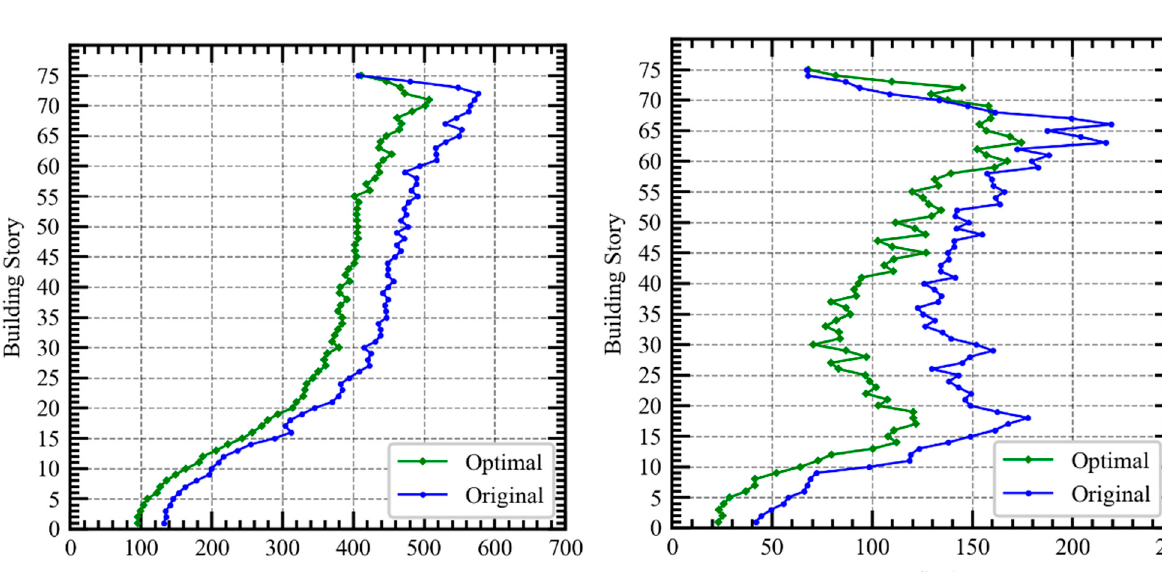
Figure 22. Imposed wind loads on building.